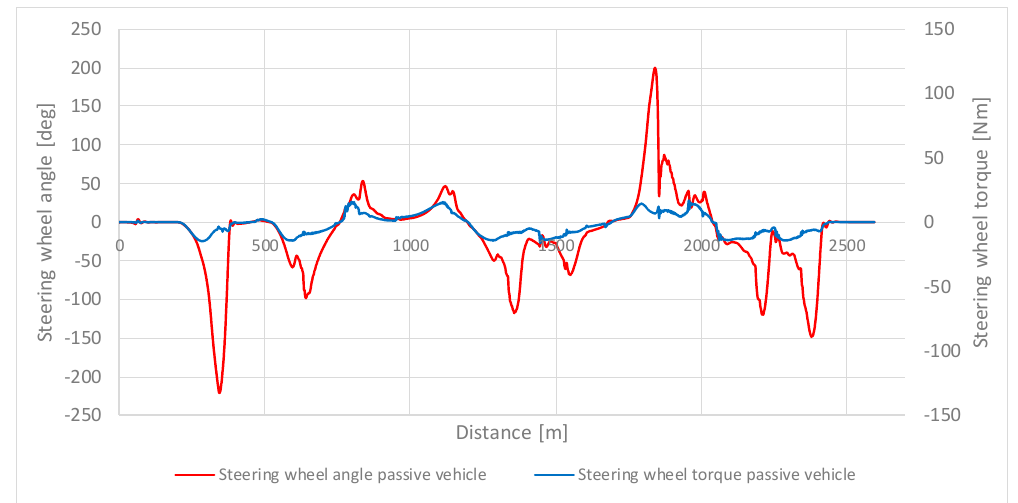
Figure 22. The passive vehicle: steering wheel angle (red) and steering wheel torque (blue).